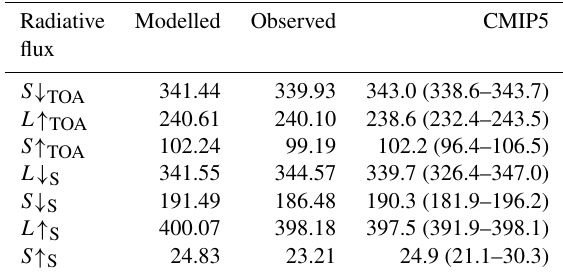
Table 3. Comparison of the globally averaged modelled (base run) and observed radiative fluxes (Wm − 2 ) for all-sky conditions for the period 2006–2010. The CMIP5 values and their range are also